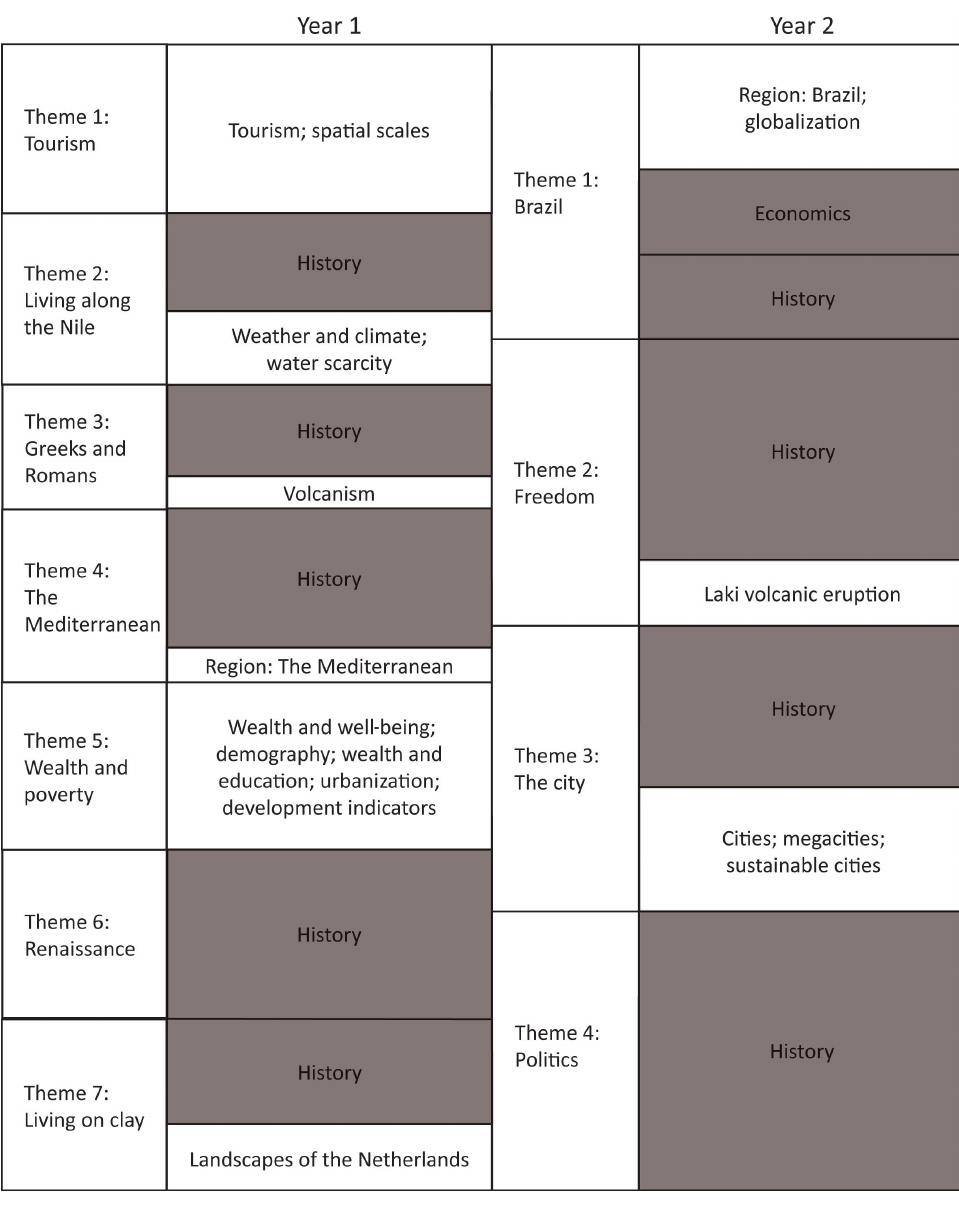
Figure 2: The ‘human and society’ curriculum at School A Note: The size of the geographical content components are adjusted according to the proportion of the component within the total ‘human and society’ curriculum per